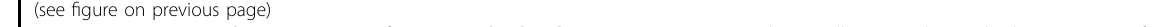
Fig. 6 LDHA promotes the transcription of genes involved in the EMT process. A Venn diagram illustrating the overlap between genes from the RNA-Seq data after LDHA knockdown and genes from the ChIP-Seq data of H3K27ac modi fi cation in B-CPAP cells. B Summary of the signi fi cantly enriched pathways of the downregulated genes bound by H3K27ac. C RNA-Seq peaks of CTNNB1, RHOB, and TGF β R1 treated with LDHA knockdown, as well as H3K27ac binding peaks, are shown. D ChIP-qPCR was performed with B-CPAP cells using H3K27ac and IgG antibodies to determine the expression levels of CTNNB1, RHOB, and TGF β R1. E Intracellular acetyl-CoA levels were measured in B-CPAP cells treated with LDHA knockdown. F H3K27ac levels were decreased after LDHA knockdown in B-CPAP cells. G , H Western blot assays showed the changes in TGF β R1, phosphorylated Smad3, E-cadherin, N-cadherin, and Slug in B-CPAP cells with LDHA knockdown and in KTC-1 cells expressing LDHA. I Transwell assays indicated that the knockdown of TGF β R1 partially reversed the increased migration and invasion ability of KTC-1 cells expressing LDHA. The data are presented as the mean ± SD. J KTC-1 cells stably expressing LDHA were infected with siRNA targeting TGF β R1. Western blotting was used to detect the expression levels of TGF β R1 and the phosphorylation levels of Smad3, E-cadherin, N-cadherin, and Slug. All * p < 0.05, ** p < 0.01, *** p <